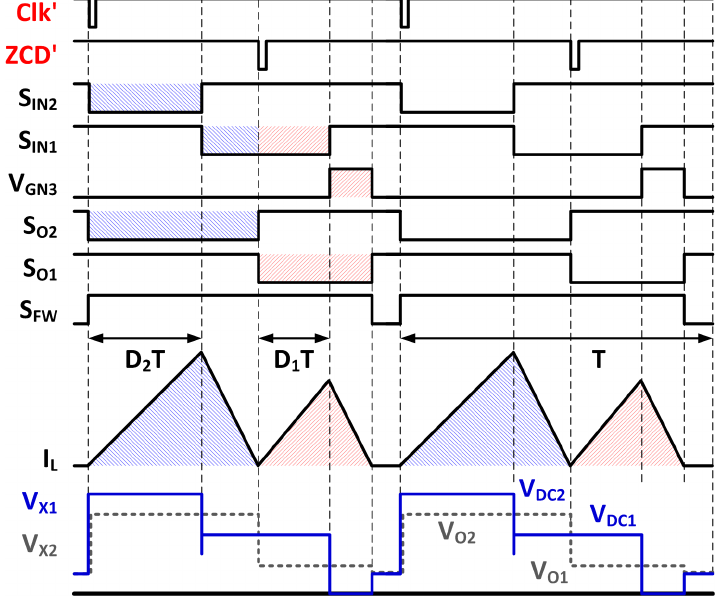
Figure 14. Voltage and current waveforms of the three-level SIDO converter operating in DCM [27].